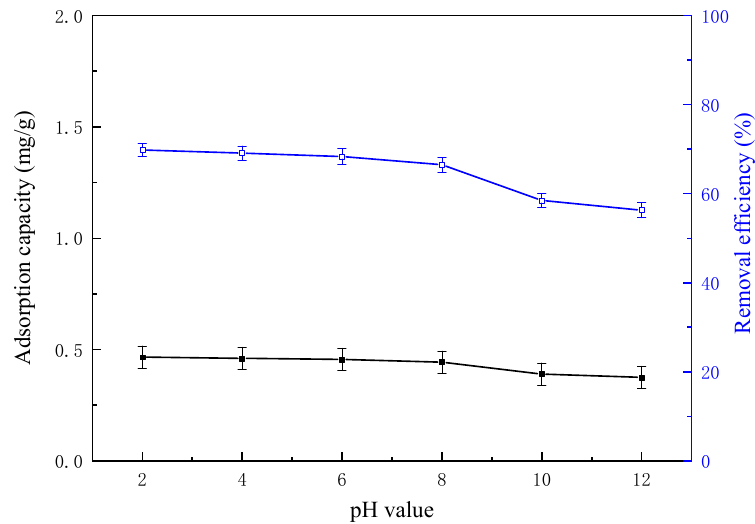
Figure 8. The effect of pH value on pyridine removal efficiency and adsorption capacity of pyridine.